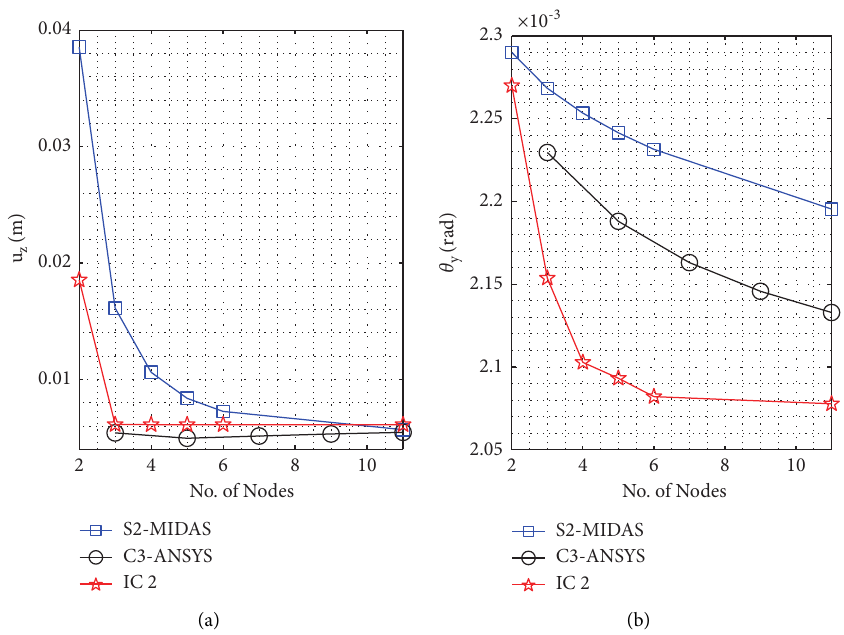
Figure 5: Influences of element types and no. of divided nodes on the numerical solutions of (a) u